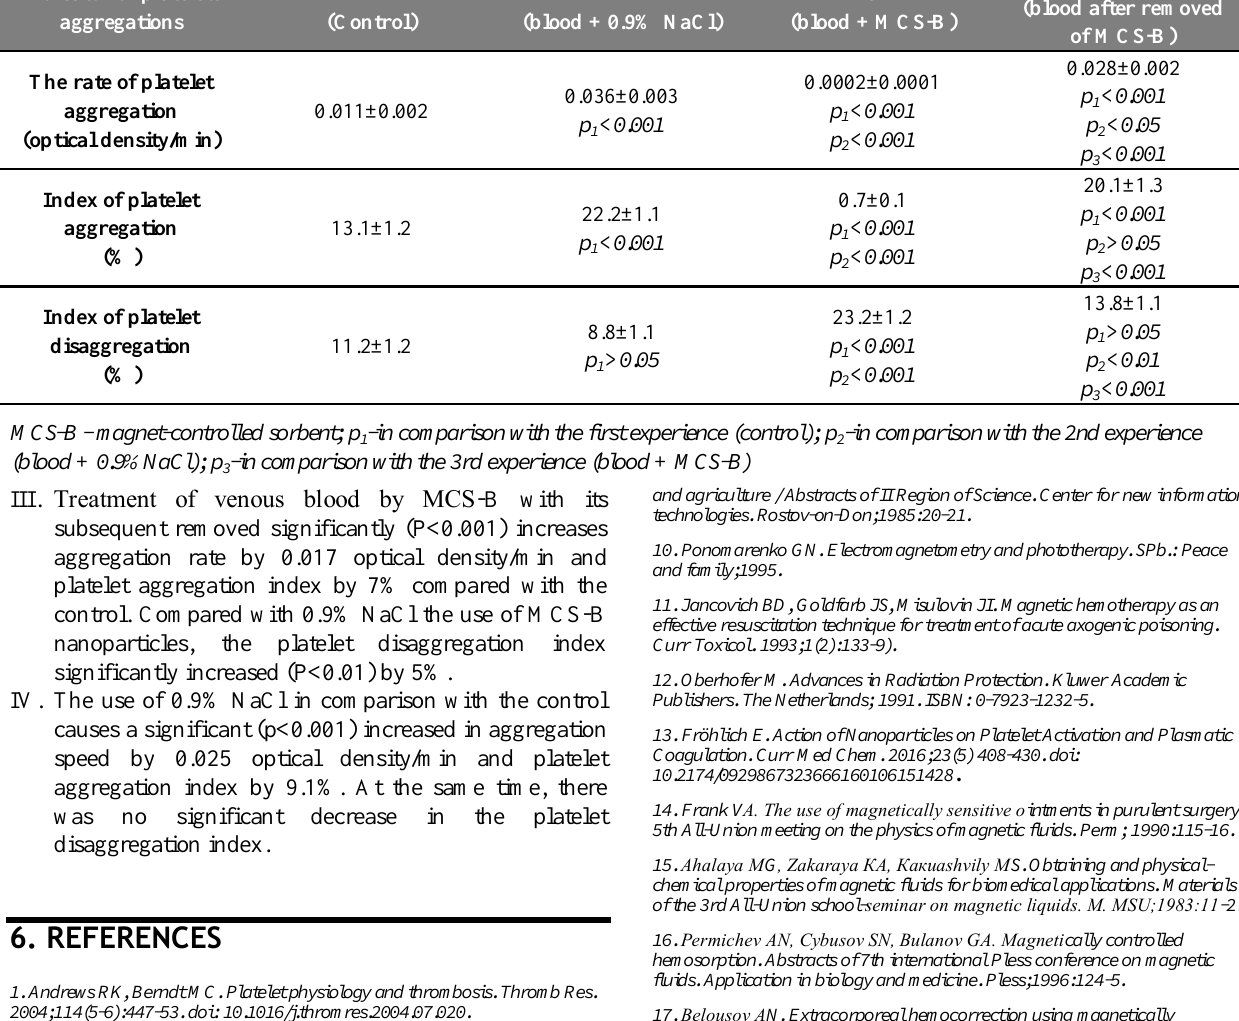
Table 1: Influence of different variants of solutions for blood treatment on platelet aggregation (n = 14; M±m) Indicator of